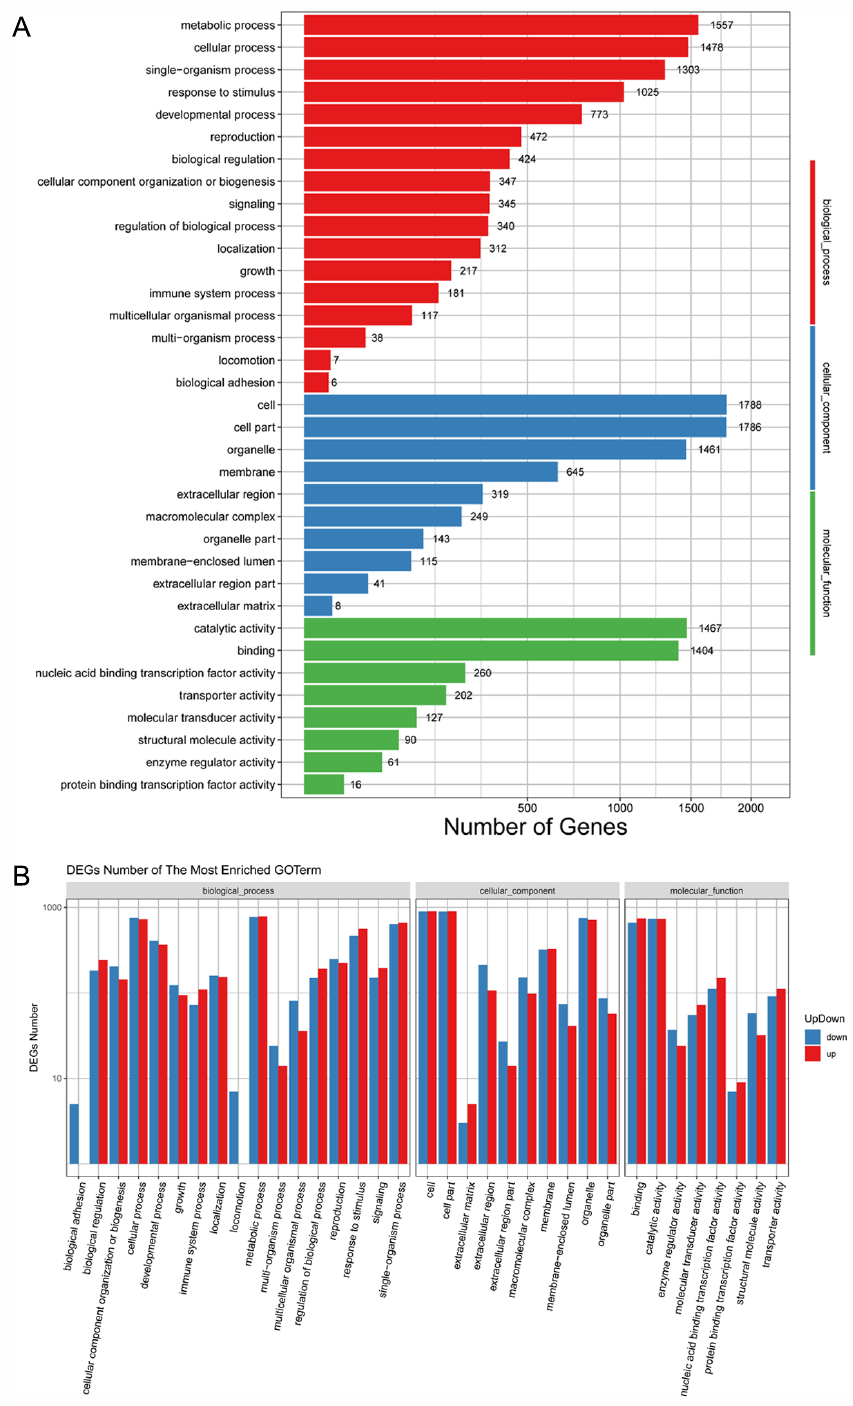
Figure 3. GO functional enrichment analyses of the differentially expressed genes (DEGs) in group 22-22 vs. 22-14. ( A ) GO functional enrichment analyses of the DEGs in group 22-22 vs. 22-14. ( B ) GO functional enrichment analyses of up- and downregulated genes in group 22-22 vs.